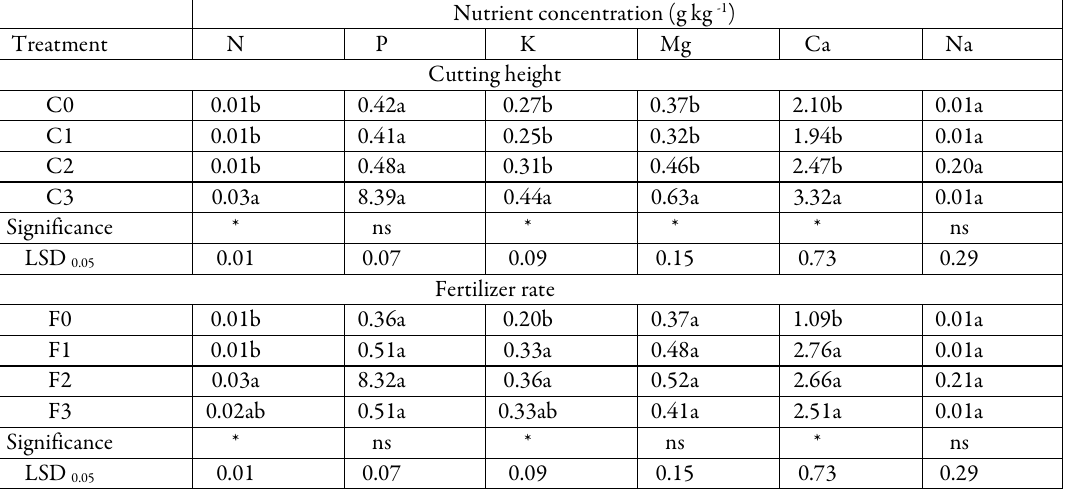
Table 4. Effect of cutting heights and fertilizer applications on nutrient concentration of Amaranthus cruentus